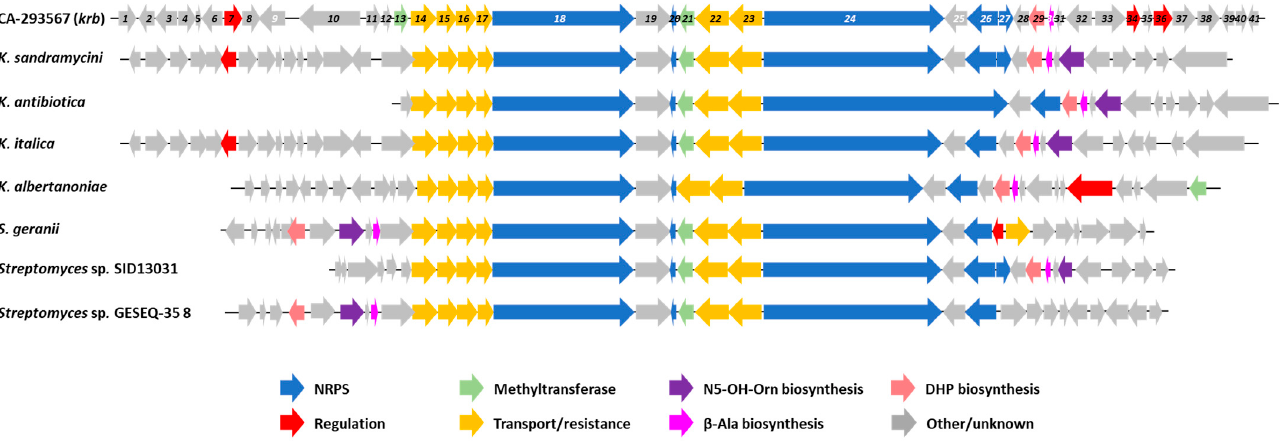
Figure 7. BiG-SCAPE sequence similarity networks visualized in Cytoscape. Each colour represents one Kribbella strain. The BGCs of sandramycin and kribbellichelins are indicated.